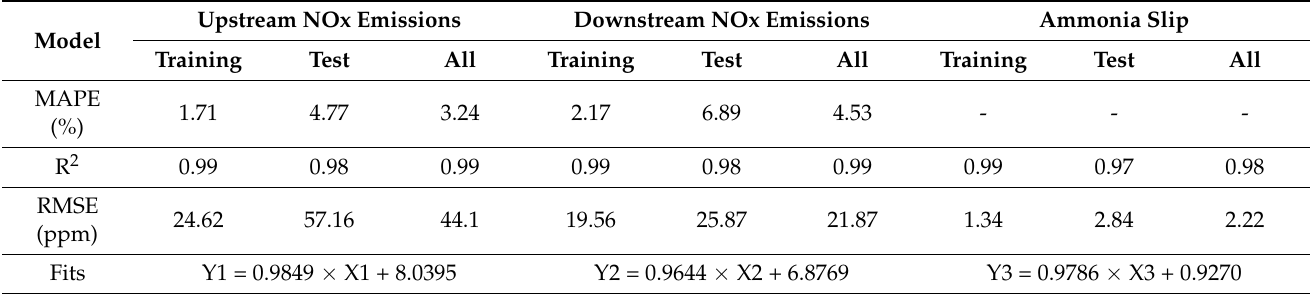
Table 8. The statistical models, adapted from Liu et al.